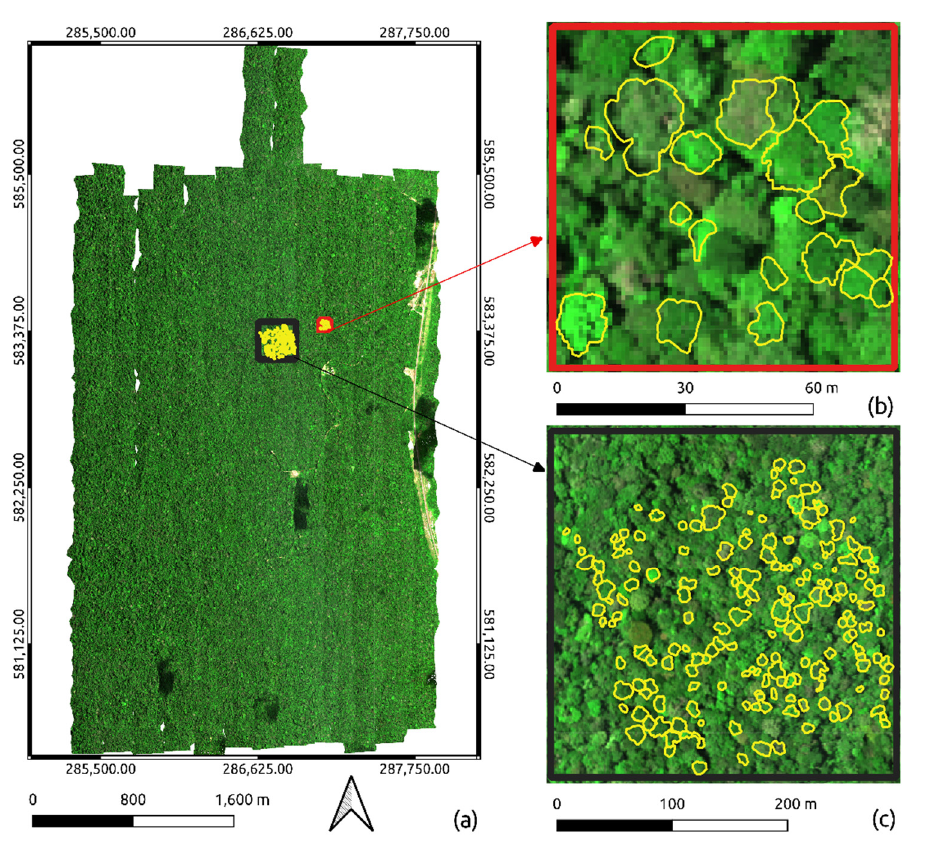
Figure 1. Red, green and blue (RGB) composite of airborne imaging spectroscopy acquired (R: 665 nm, G: 560 nm, B: 490 nm): ( a ) over the study site; ( b ) Site A; ( c ) Site B. Delineated individual tree crowns ( ITCs ) are represented by yellow polygons.